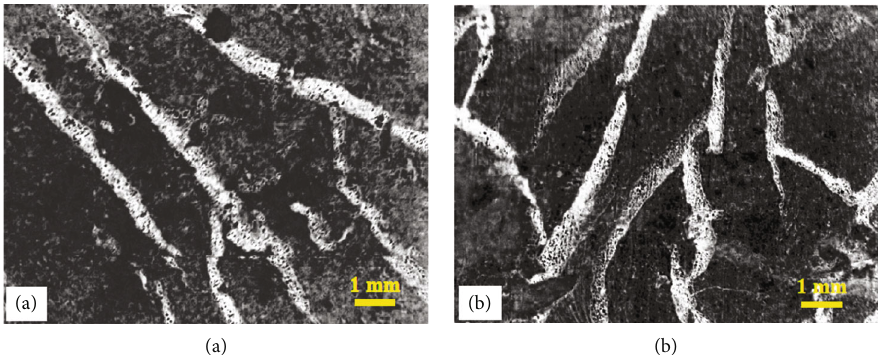
Figure 7: Macroscale images of a frozen soil cryo-structure with a moisture content of 37% at temperatures of -5 ° C in (a) and -3 ° C in